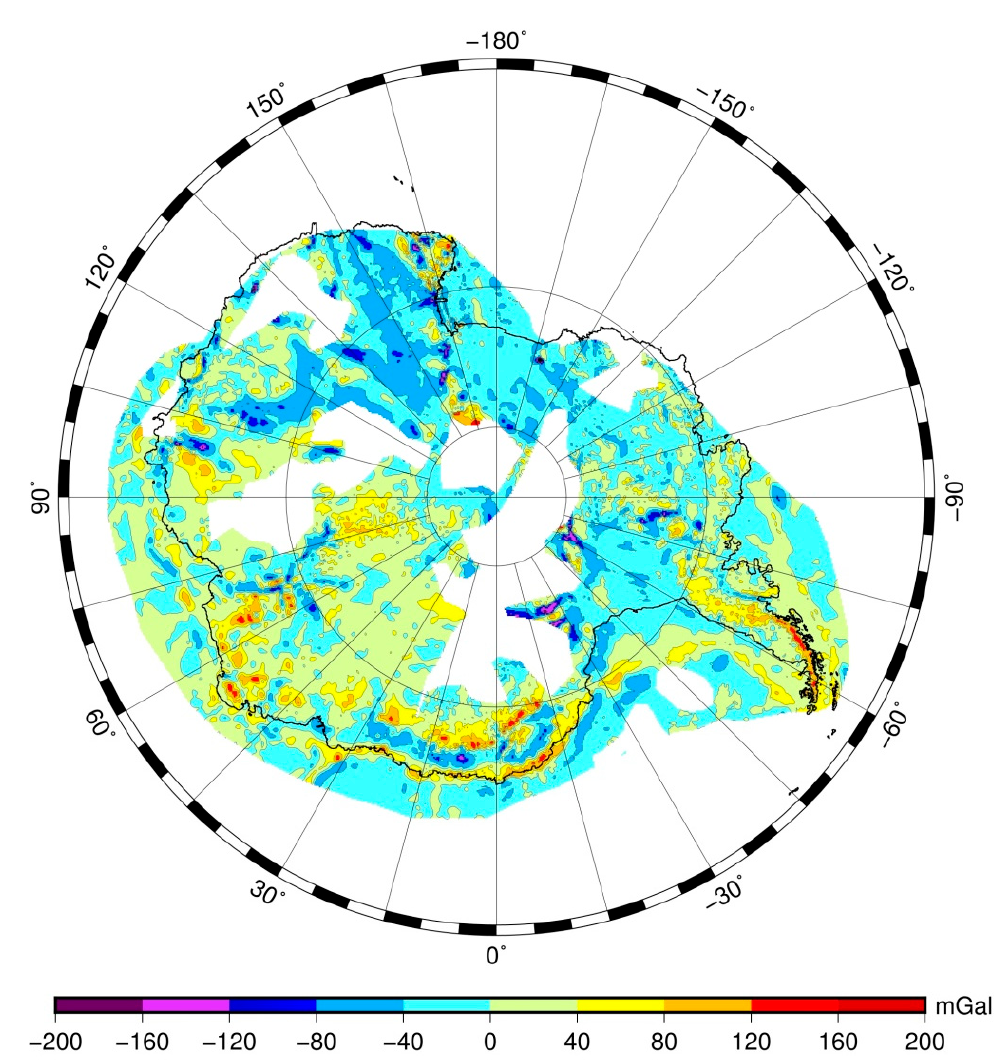
Figure 13. Gridded data of FAG anomalies (mGal) at continental scale (contour interval at 40 mGal).